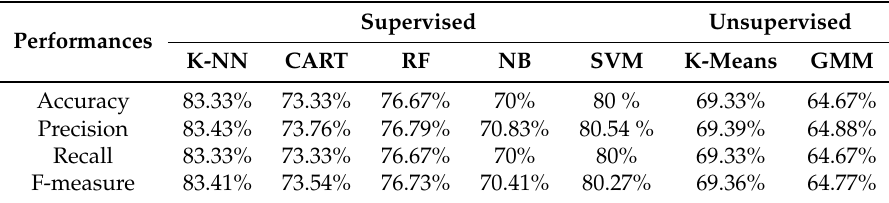
Table 13. Accuracy, Precision, Recall and F-measure for each classifier, obtained from the binary classification between PD and HD subjects.